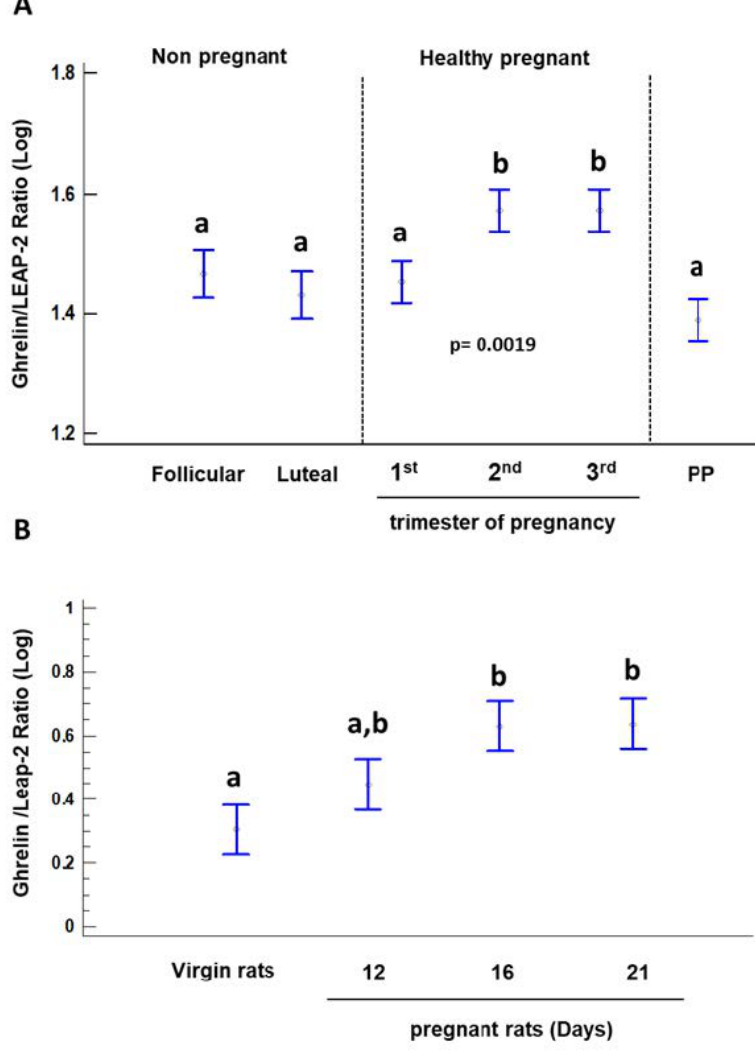
Figure 1. The Ghrelin/LEAP-2 ratio (Log) in healthy pregnant women at each trimester of gestation and during the follicular and luteal phases of the menstrual cycle ( A ) and Ghrelin/LEAP-2 ratio during pregnancy in rat ( B ). A p value of < 0.05 was considered as statistically significant. Mean Log [(Ghrelin ng/mL) × 10)]/Log [(LEAP-2 ng/mL) × 10] were used. Bars with no common letters are significantly different ( p < 0.05).